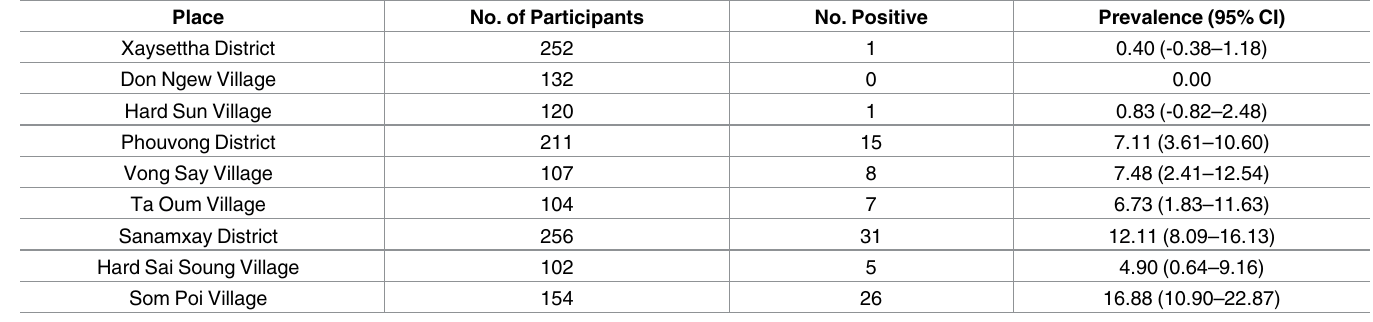
CI, confidence interval.